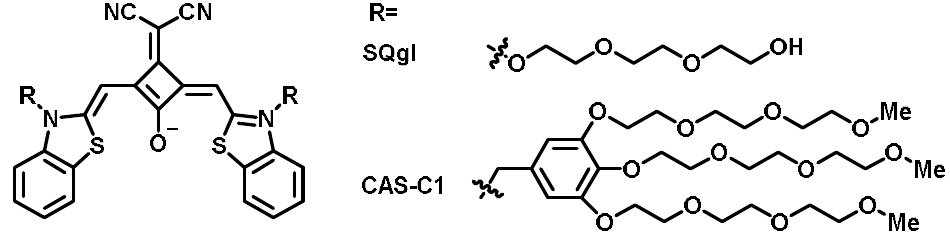
Figure 17. Structures of SQgI and CAS-C1.